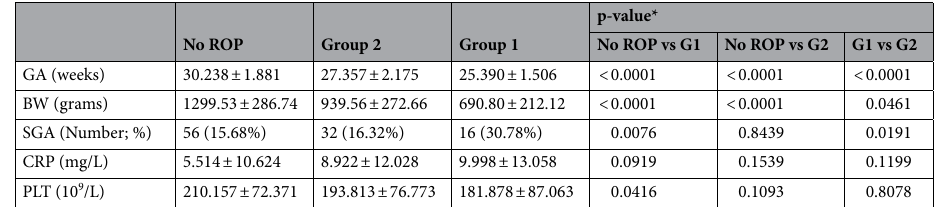
Table 2. Comparison of clinical parameters (GA, BW, SGA, CRP and PLT) among the three groups NoROP, Group 2 and Group 1. ROP retinopathy of prematurity; BW birth weight; GA gestational age; SGA small for gestational age; CRP C-reactive protein; PLT platelets; G1 Group 1 including Type 1 ROP and Aggressive Posterior ROP, requiring treatment; G2 Group 2 including Type 2 ROPs and mild ROPs with self regression.